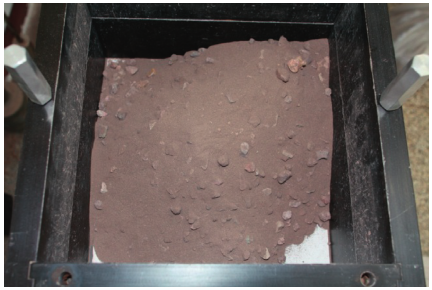
Figure 8: Photograph of rock-soil mixture